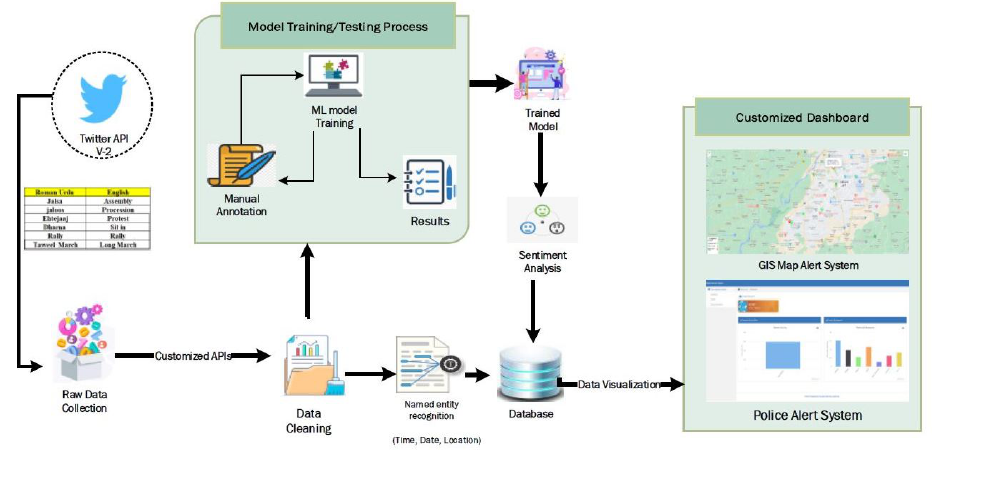
Figure 1. Detailed process